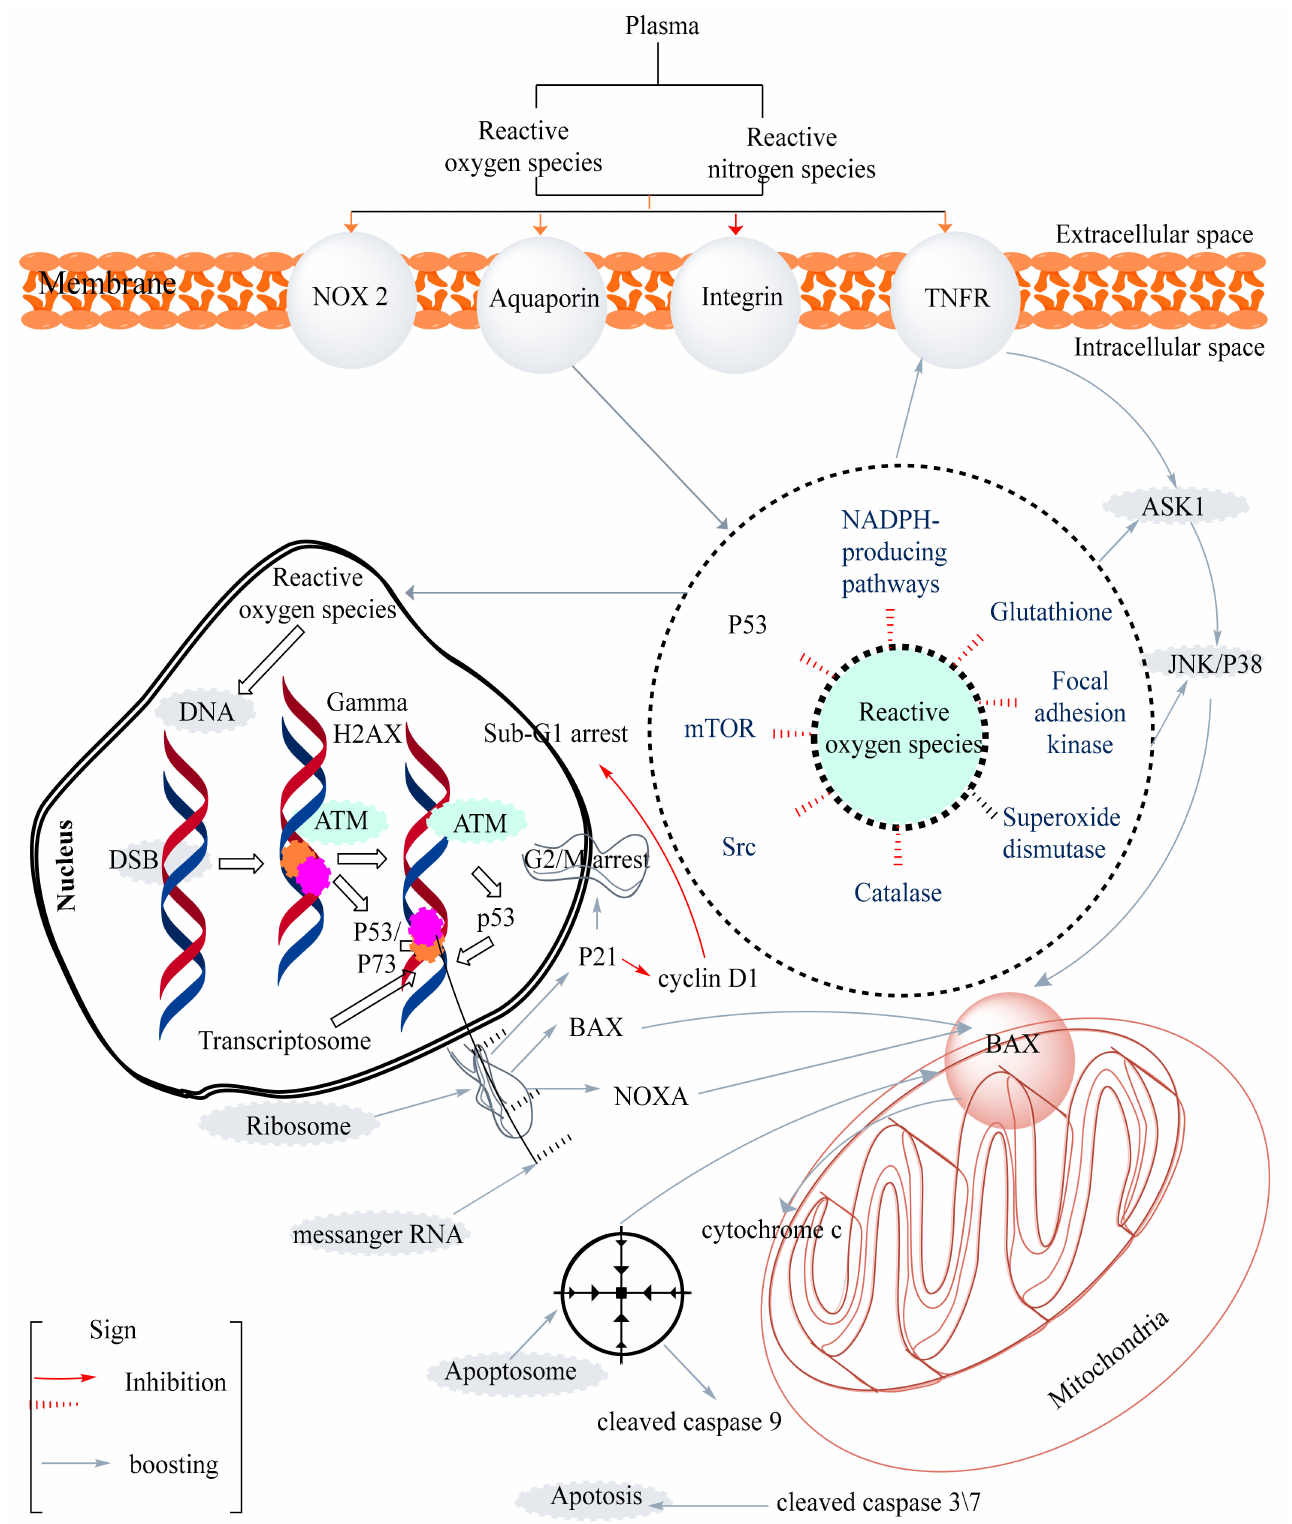
Figure 2. The mechanism of action of the anticancer activity